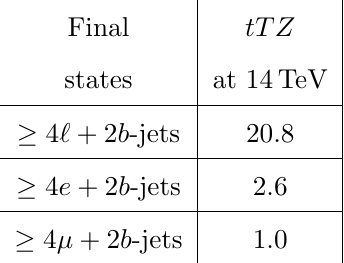
Table 5. Final state numbers for 4 ‘; 4 e; 4 (cid:22) along with 2 b -jets for the dominant SM